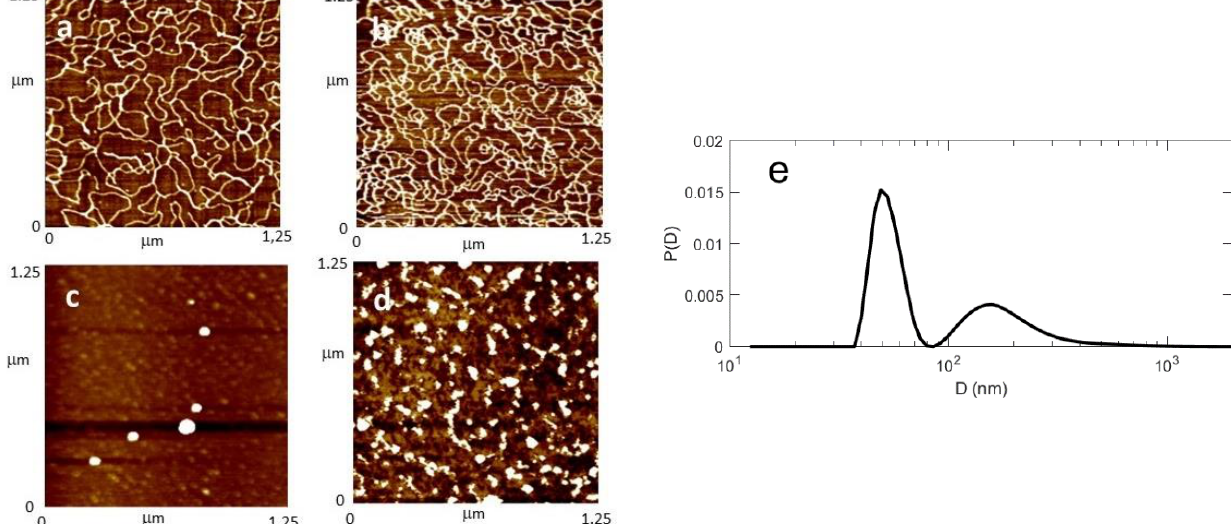
Figure 5. ( a – d ) are AFM images showing the effect induced on DNA plasmid by incubation with the compounds under study: ( a ) plasmid alone; ( b ) plasmid + GP16_6; ( c ) plasmid + FGP6; ( d ) plasmid + FGP8. All images were obtained with supercoiled 0.5 nM pEGFP-C1 plasmid deposited onto mica and with the microscope operating in tapping mode in air at the same N / P ratio as transfection. For image d, see Ref. [21]. ( e ) DLS volume distribution of plamid + FPG6, the same sample as ( c ).